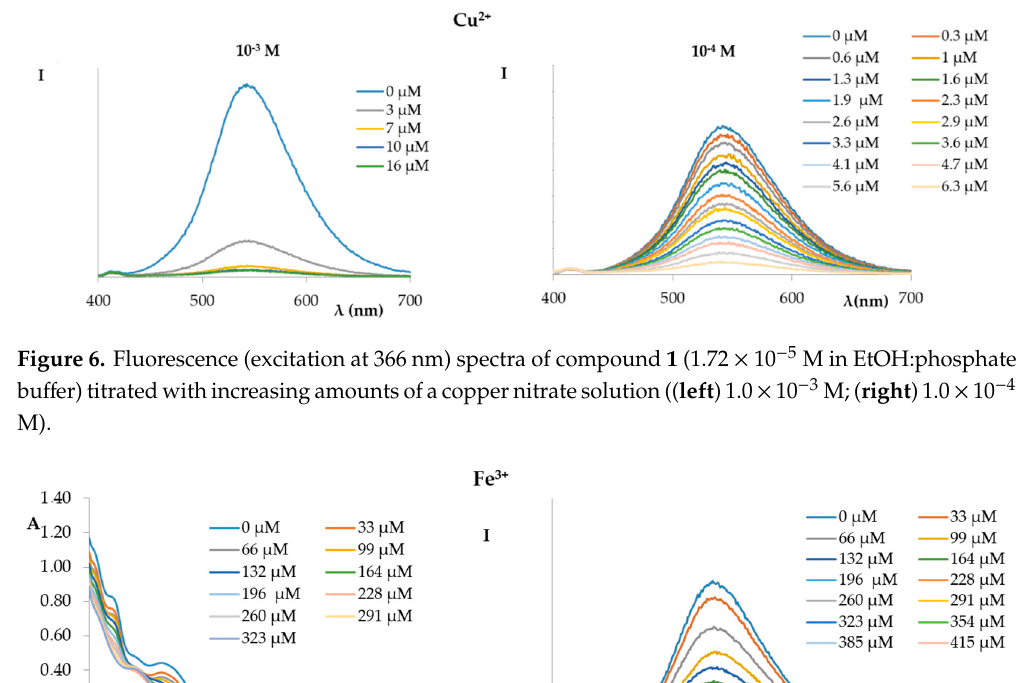
Figure 7. UV spectra ( left ) and fluorescence spectra ( right ) (excitation at 366 nm) of compound 1 (1.72 × 10 − 5 M in EtOH:phosphate buffer) titrated with an increasing amount of Fe 3+ (1.0 × 10 − 2 M in phosphate buffer).